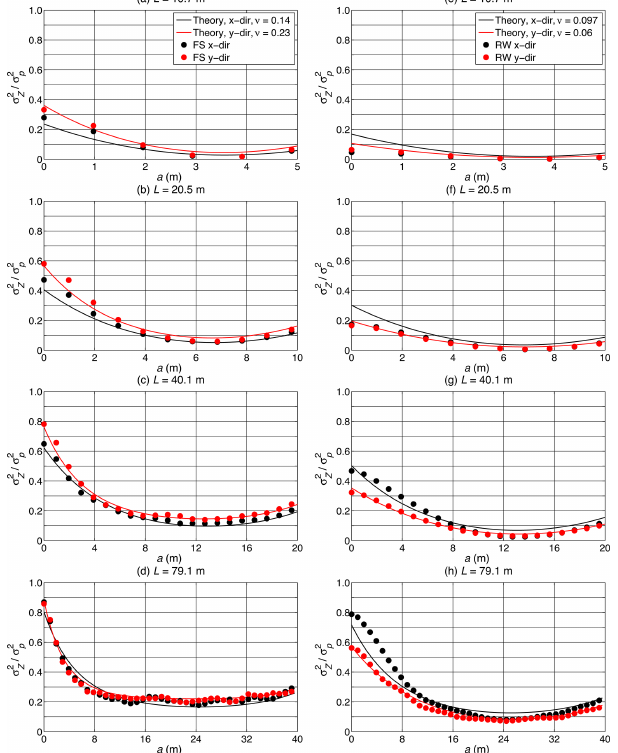
Figure 9. Theoretical and sampled normalized squared error . σ 2 p ) for the three-point pattern along a profile section in ( σ 2 Z Fig. 5b, and for profile section lengths ( L ) between 10 and 80m in FS and RW. The solid lines are the theoretical error from Eq. (8) using exponential decay exponents derived from the functions fit- ted to the sampled correlation functions of the two surfaces in the x and y directions, while the dots correspond to the sampled error for profiles in FS (a–d) and RW (e–h) .